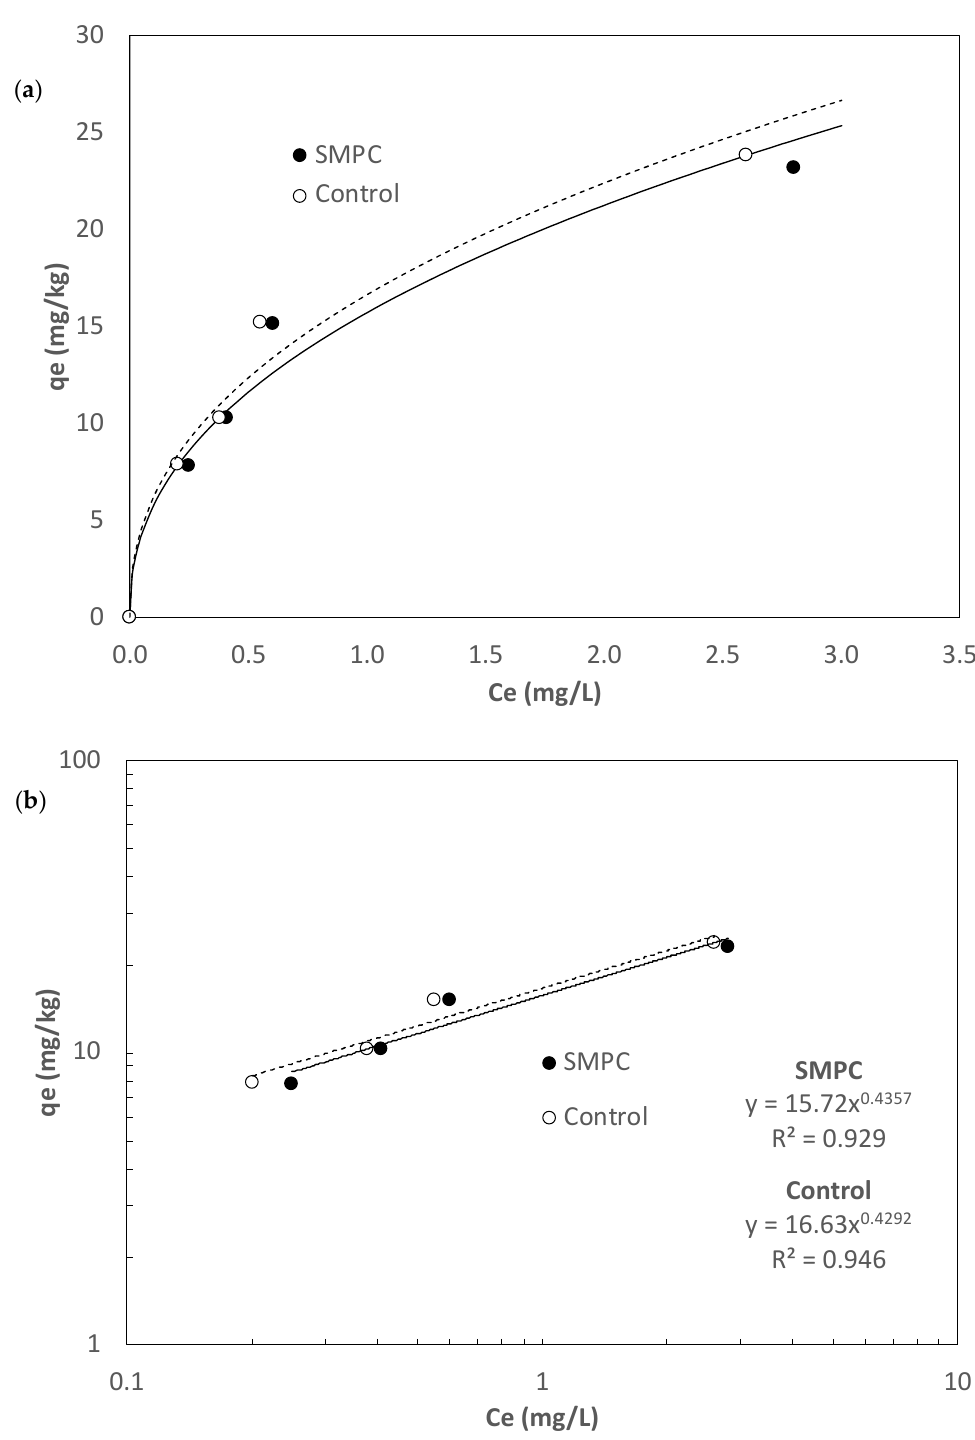
Figure 4. Results from the isotherm study: ( a ) a non-linear isotherm data and ( b ) isotherm data fitted with the Freundlich equation.